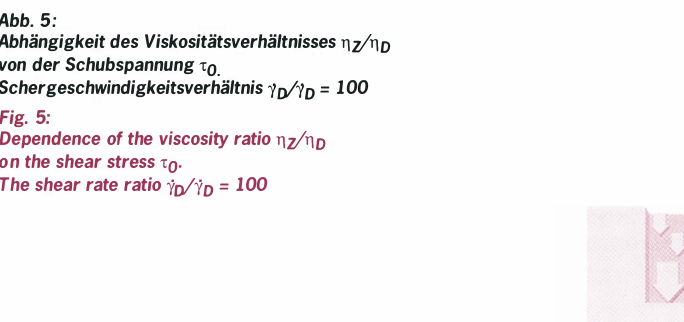
height L(t) increases, because the second term in the parenthesis of equation (18)